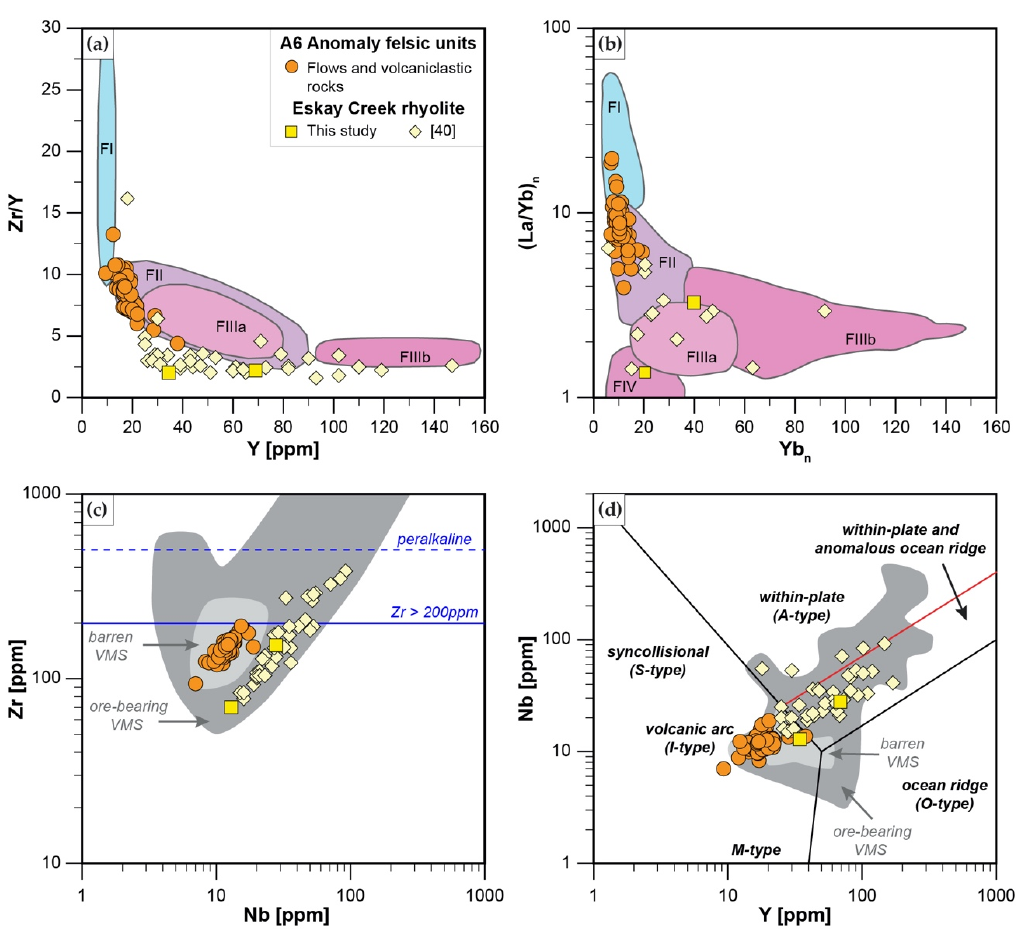
Figure 20. Discrimination of felsic lithologies at A6 Anomaly and Eskay Creek regarding their VMS potential, ( a ) Y vs. Zr/Y plot [74] displaying different rhyolite types FI, FII, FIIa, and FIIb that can be associated with VMS systems, ( b ) Yb n vs. (La/ Yb) n plot [13,74] displaying rhyolite types FI, FII, FIIIa, FIIIb, and FIV that can be associated with VMS systems, concentrations are normalized to chondrite using values of Nakamura [56], ( c ) Nb vs. Zr plot [83] highlighting barren (light grey) and ore-bearing (dark grey) VMS systems [15,16], ( d ) Y vs. Nb plot [84] showing the tectonic setting for felsic rocks with areas highlighting barren (light grey) and ore-bearing (dark grey) VMS systems [15,16].